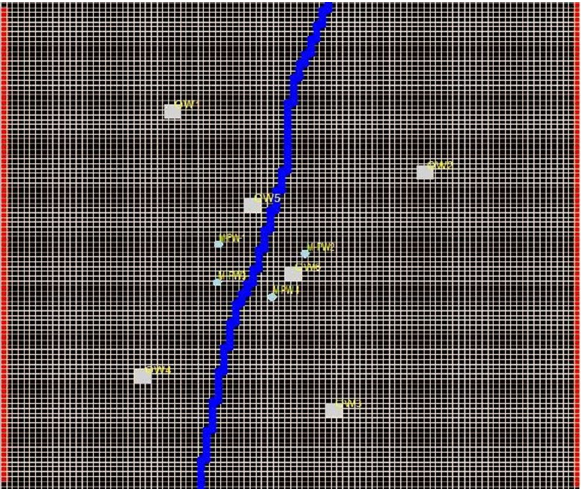
Fig. 1 Grid map of the of study